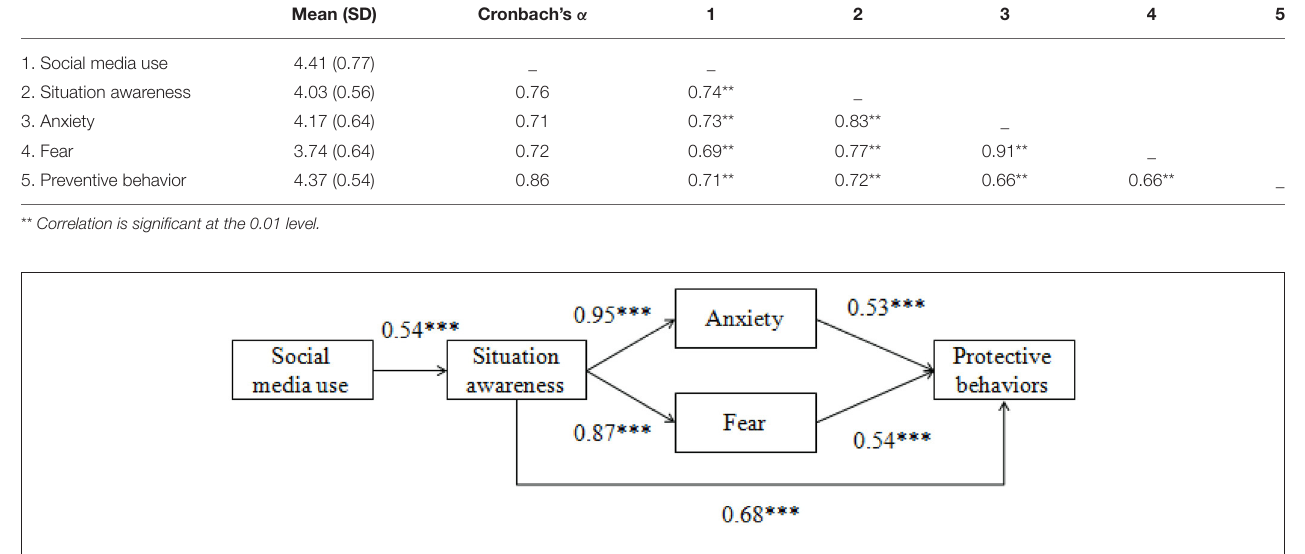
FIGURE 2 | Results of hypothesized model. *** p < 0.001.